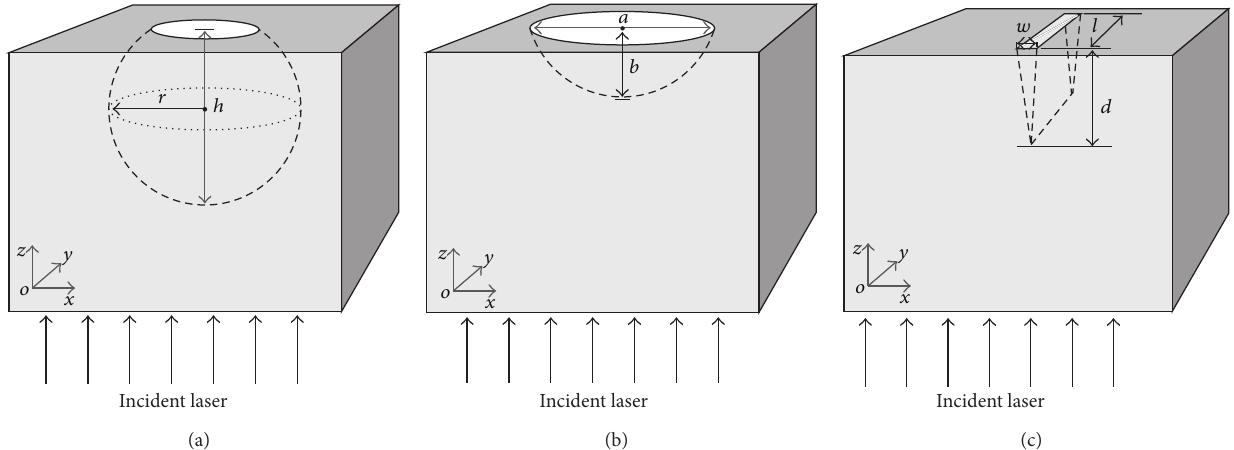
Figure 2: The three-dimensional profiles of models for the microdefects in Figure 1: (a) sphere, (b) rotated parabolic body, and (c) straight triangular